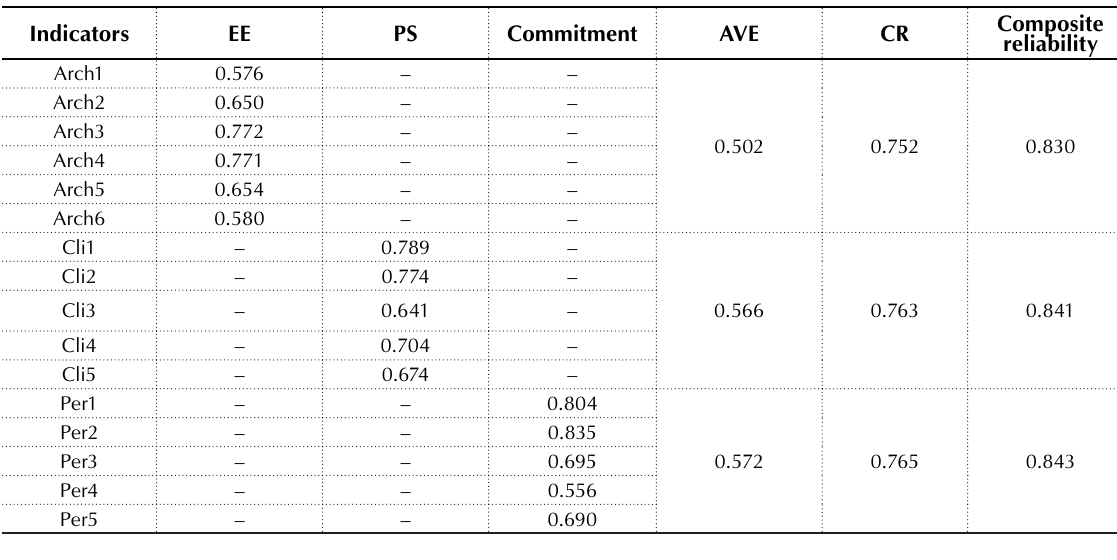
Table 5. Result of path analysis